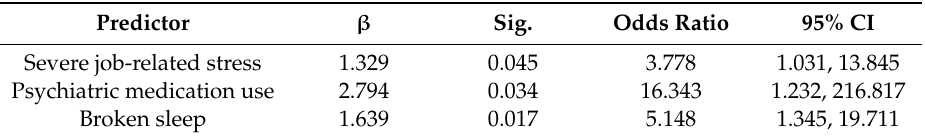
Table 3. Regression coe ffi